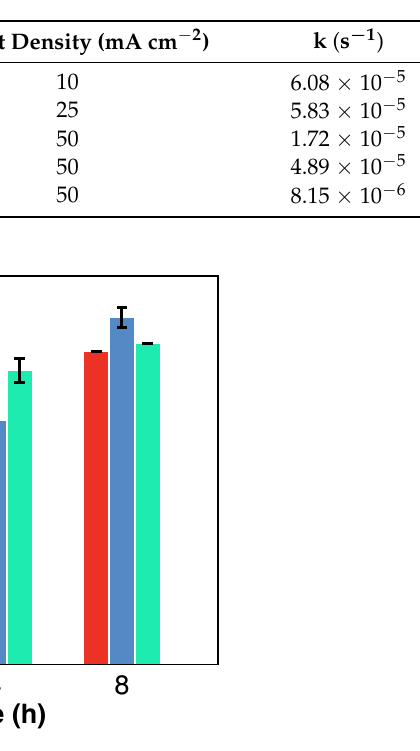
Table A6. Values of fluoride pseudo-first-order generation rate constants during the electrochemical treatment of PFAS in still bottoms.